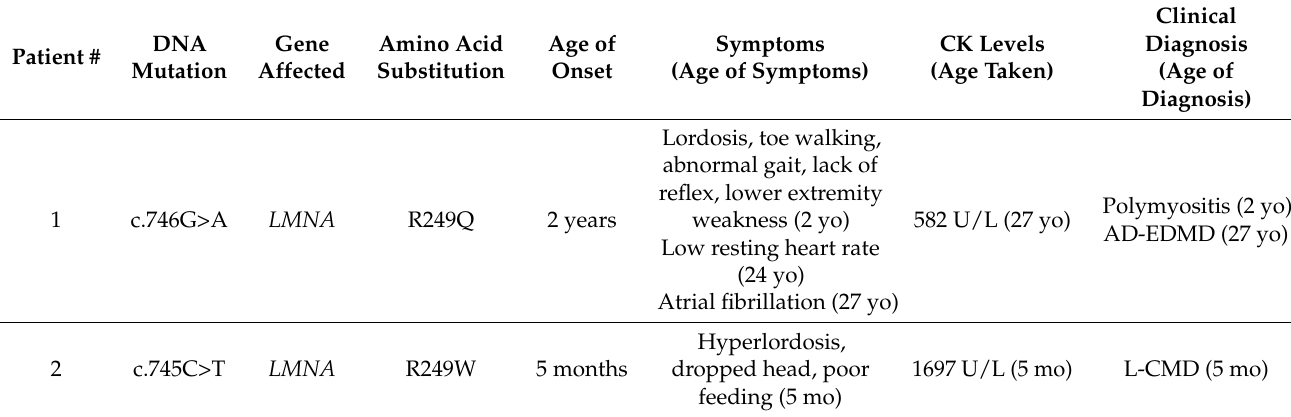
Table 1. Clinical data of individuals with muscular dystrophy that served as a basis for this study.